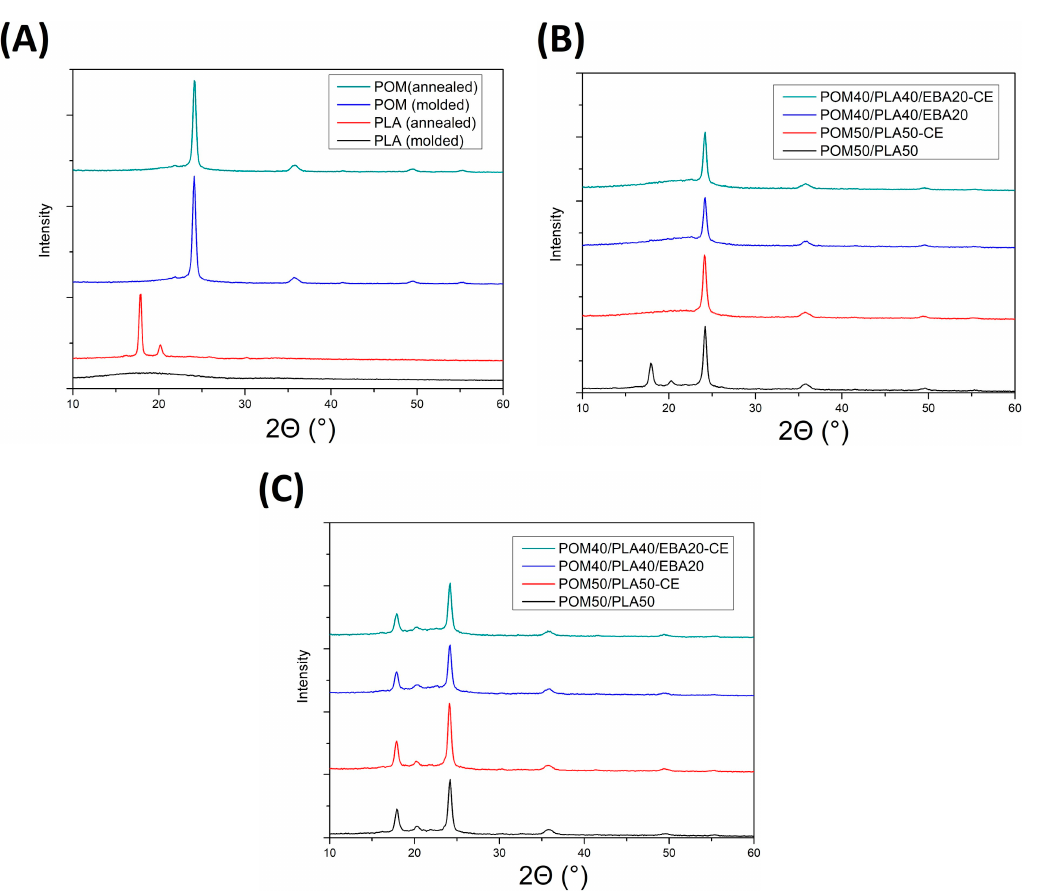
Figure 15. Wide-angle X-ray diffraction (WAXS) plots for ( A ) pure PLA and POM (molded and annealed), ( B ) molded POM/PLA blends, and ( C ) annealed POM/PLA blends.